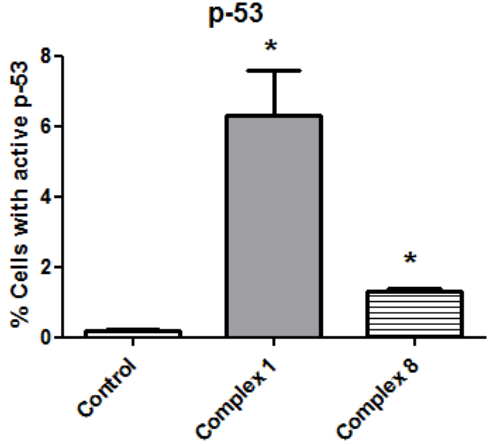
Figure 5. Percentage of Caco-2 cells with the presence of active p53. Studies by flow cytometry